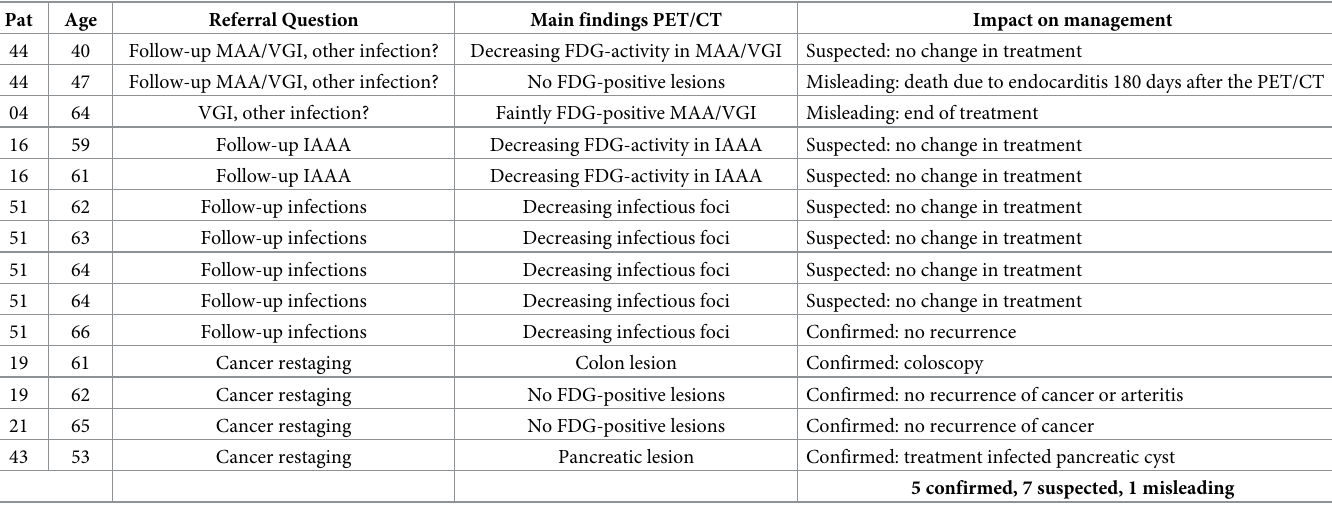
Table 8. Impact on patient management of follow-up PET/CT scans with the various referral questions (n = 14). Pat